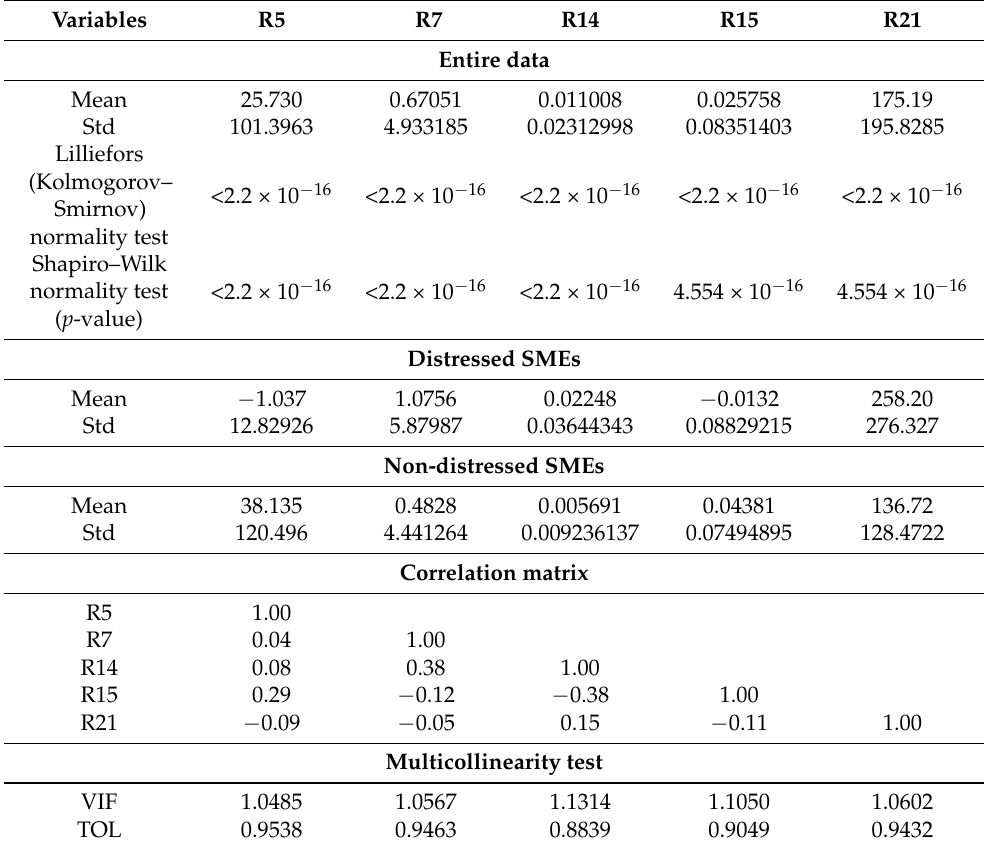
Table A1. Descriptive statistics for variables selected by stepwise technique, year 2017.